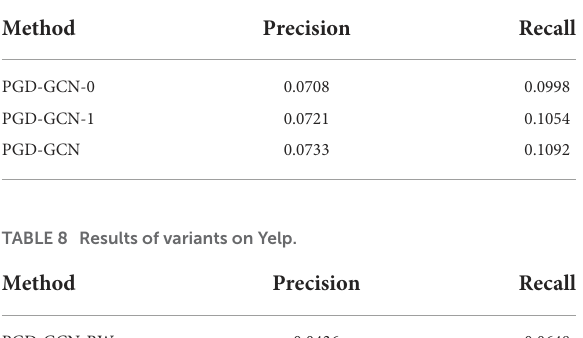
TABLE 7 Results of variants on Gowalla.